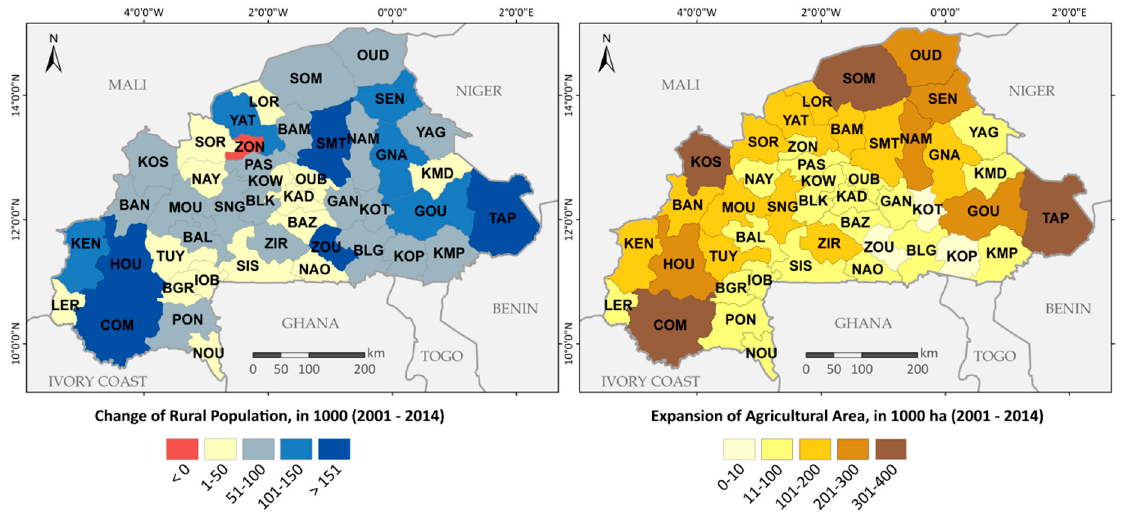
Figure 9. Change of rural population in the provinces of Burkina Faso between 2001 and 2014 ( left ) [35] and expansion of agricultural area in the provinces derived from the classification results ( right ); the province names are abbreviated by three letters.